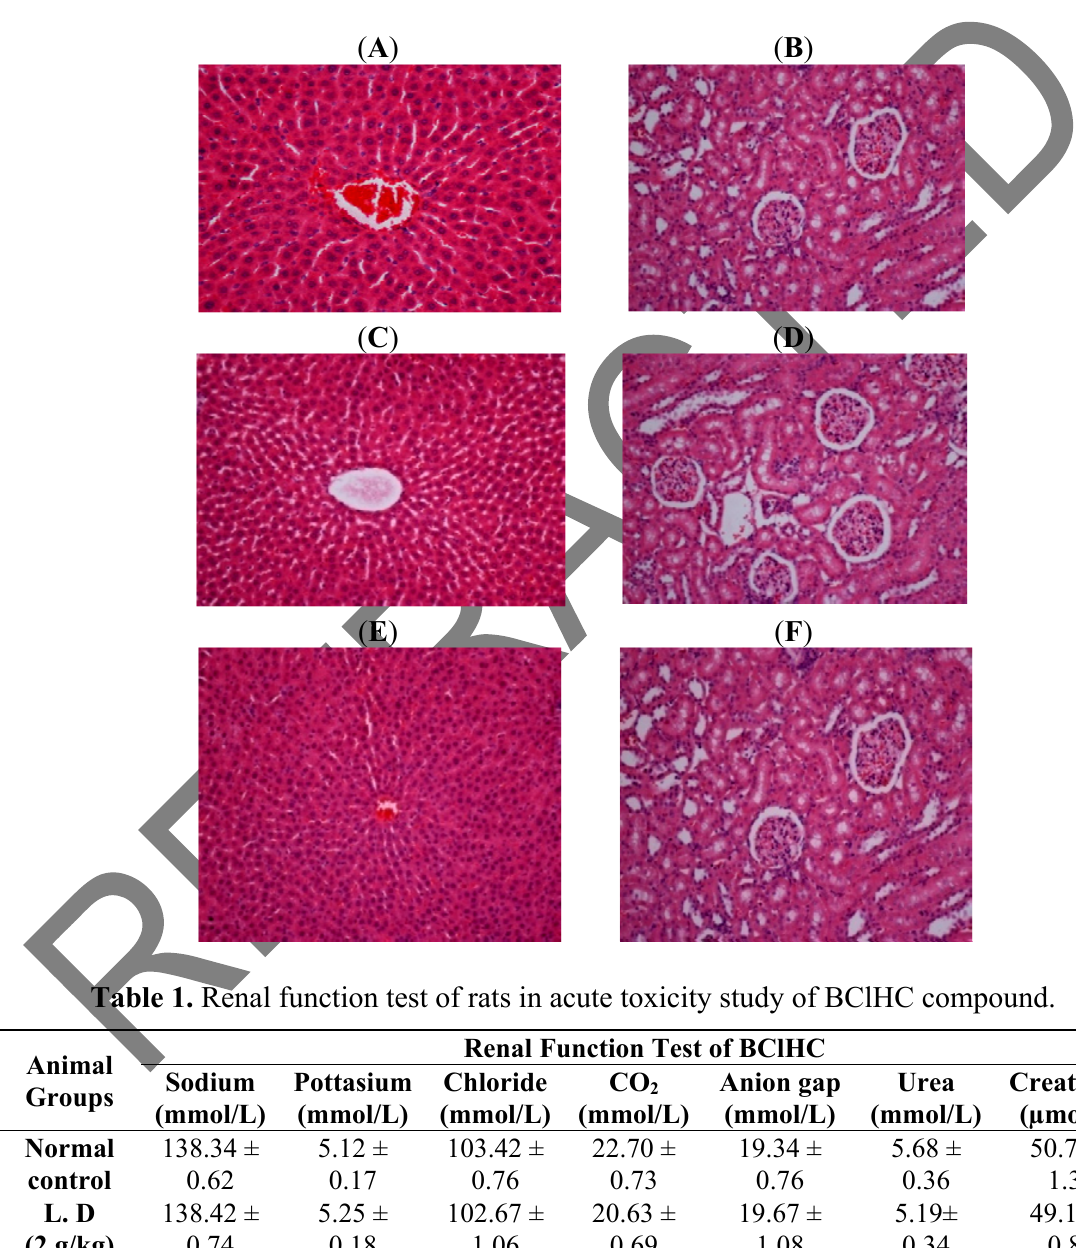
Figure 1. Histological sections of liver and kidney in subacute toxicity test ( A ) liver of rats treated with vehicle (10% Tween 20, 5 mL/kg) showing normal structural appearance; ( B ) kidney of rats treated with vehicle (10% Tween 20, 5 mL/kg) showing normal structural appearance; ( C ) Liver of rats treated with 2 g/kg of BClHC showing normal structural appearance; ( D ) Kidney of rats treated with 2 g/kg of BClHC showing normal structural appearance; ( E ) Liver of rats treated with 5 g/kg of BClHC showing normal structural appearance; ( F ) kidney of rats treated with 5 g/kg of BClHC showing normal structural appearance.